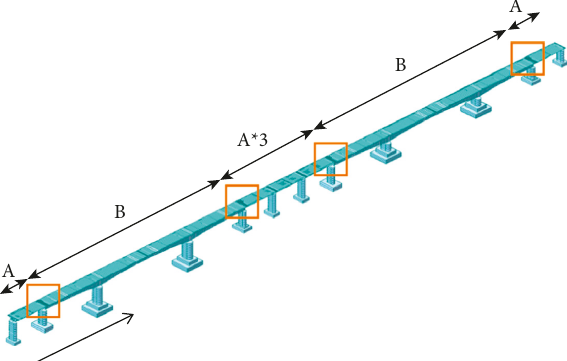
Figure 2: The MIDAS model of the